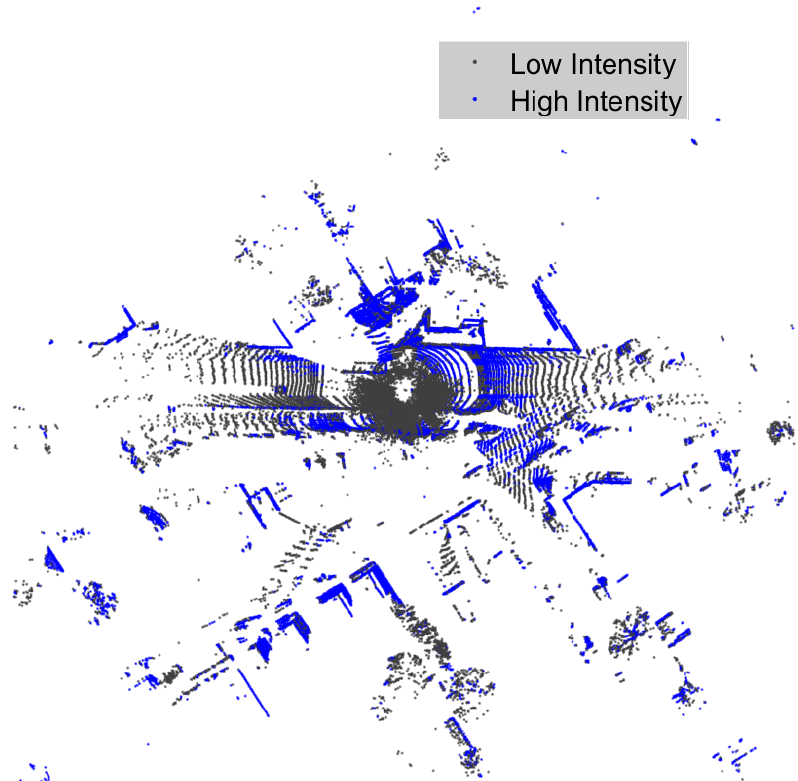
Figure 3. LiDAR point clouds after the first stage: low intensity (gray), high intensity